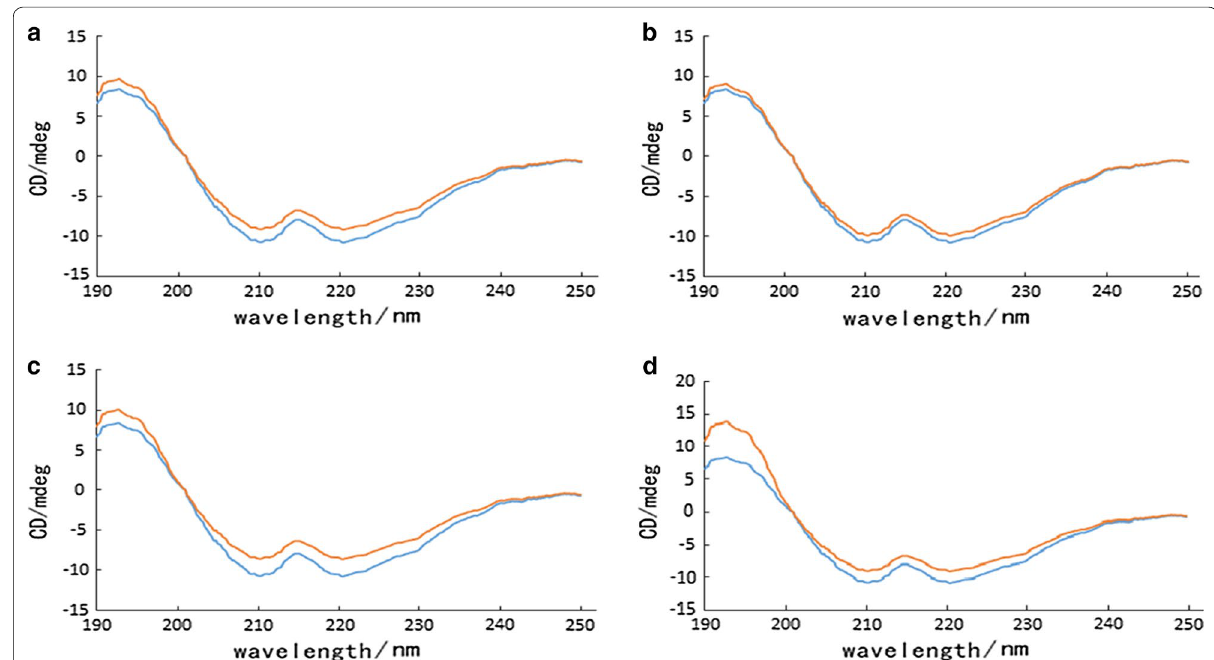
Fig. 5 The far-UV CD spectra of Cyanidin-3- O -arabinoside ( a ), Cyanidin-3- O -galactoside ( b ), Cyanidin-3- O -glucoside ( c ) and Cyanidin-3- O -Xyloside ( d ) in absence and presence of BSA